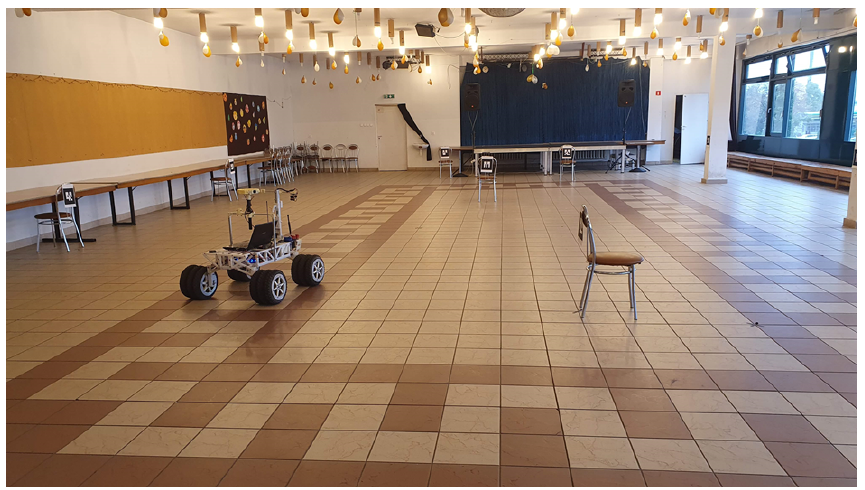
Figure 7. General overview of laboratory test